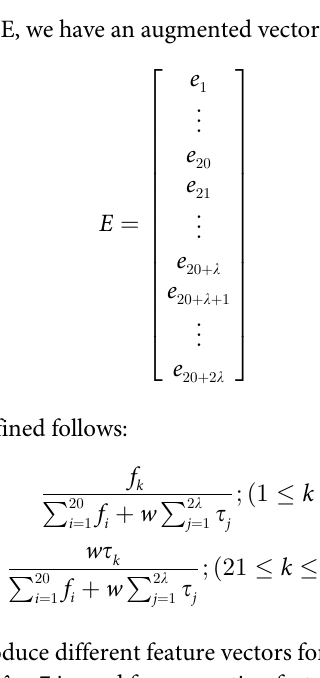
Fig 1. The amphiphilic coupling between all the third most contiguous amino acids. The values 0 and 1 for m represents the correlations via hydrophobicity and hydrophilicity indices.